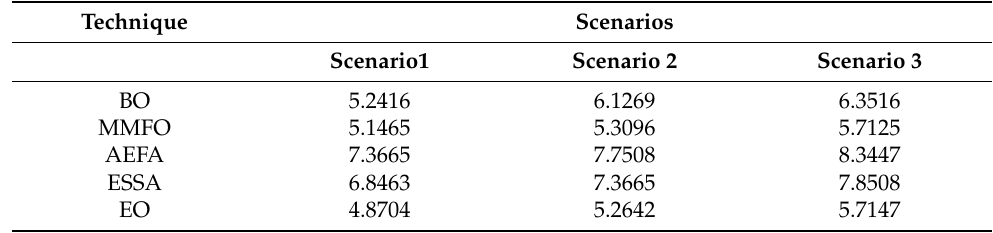
Table 10. The elapsed time (seconds) of Case 2 for all